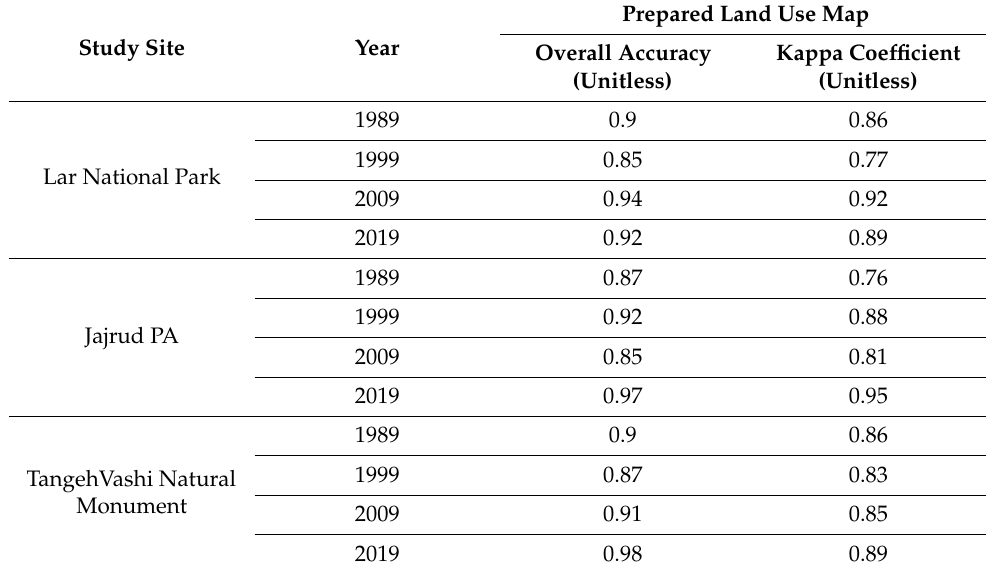
Table 3. Overall accuracy and kappa coefficient during the studied years.